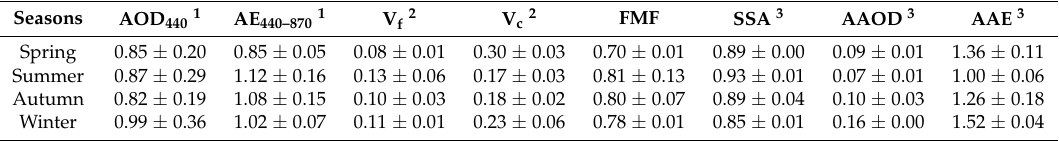
Table 2. Seasonal averages of aerosol optical and microphysical properties in